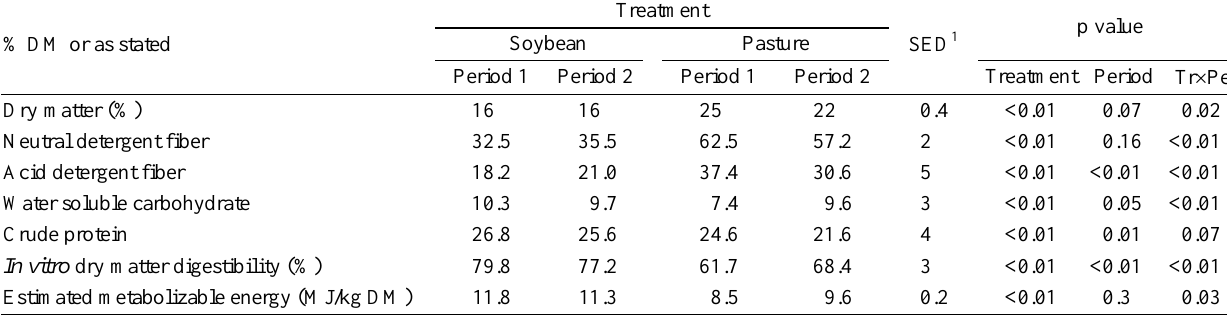
Table 2. Effects of forage type (Treatment; Tr) and period (Period; Pe) on forage chemical composition % DM or as